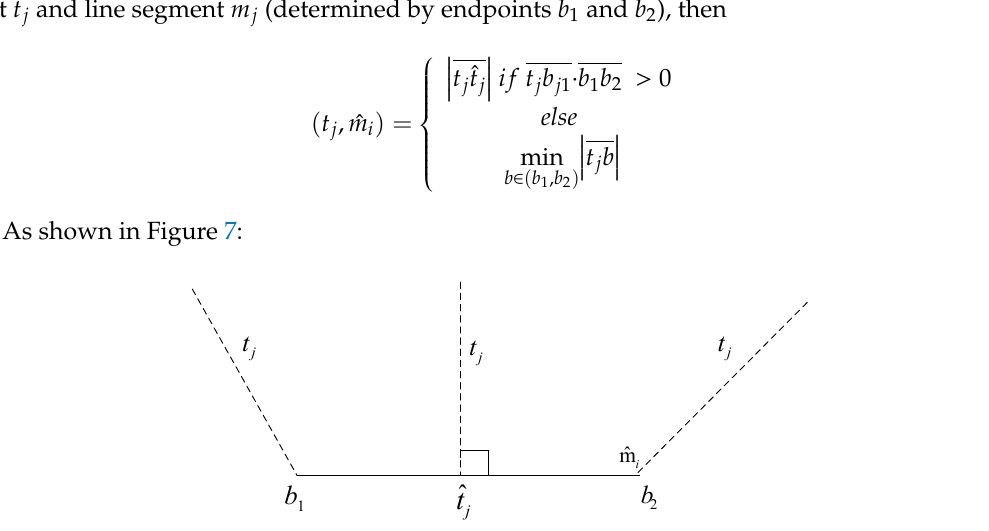
Figure 8. Simulated optimal annealing algorithm calculation process. In order to avoid duplication of content, matching results of the model are presented in the experiment section. 3.4. Pose Estimation In the visual servoing system of this paper, RGB-D camera or planar camera is fixed at the end of the robot arm. After capturing the current image, it then needs to be matched with the target image. The angle and the speed of the robot arm are obtained by inverse kinematics, which requires a composite Jacobian matrix that correlates the speed of the robot and the image change. Inspired by the registration of point cloud images [23], this section uses the RANSAC (random sample consensus) algorithm to provide an initial transformation matrix for RGB-D image fine registration. The RANSAC is an iterative algorithm for estimating the parameters of mathematical models, which are used to determine the corresponding points that satisfy a particular mathematical model, and obtain the initial transformation matrix accordingly. After applying the initial transformation matrix to RGB-D images, the LM-ICP is applied to the transformed RGB-D images and scenes, which is an